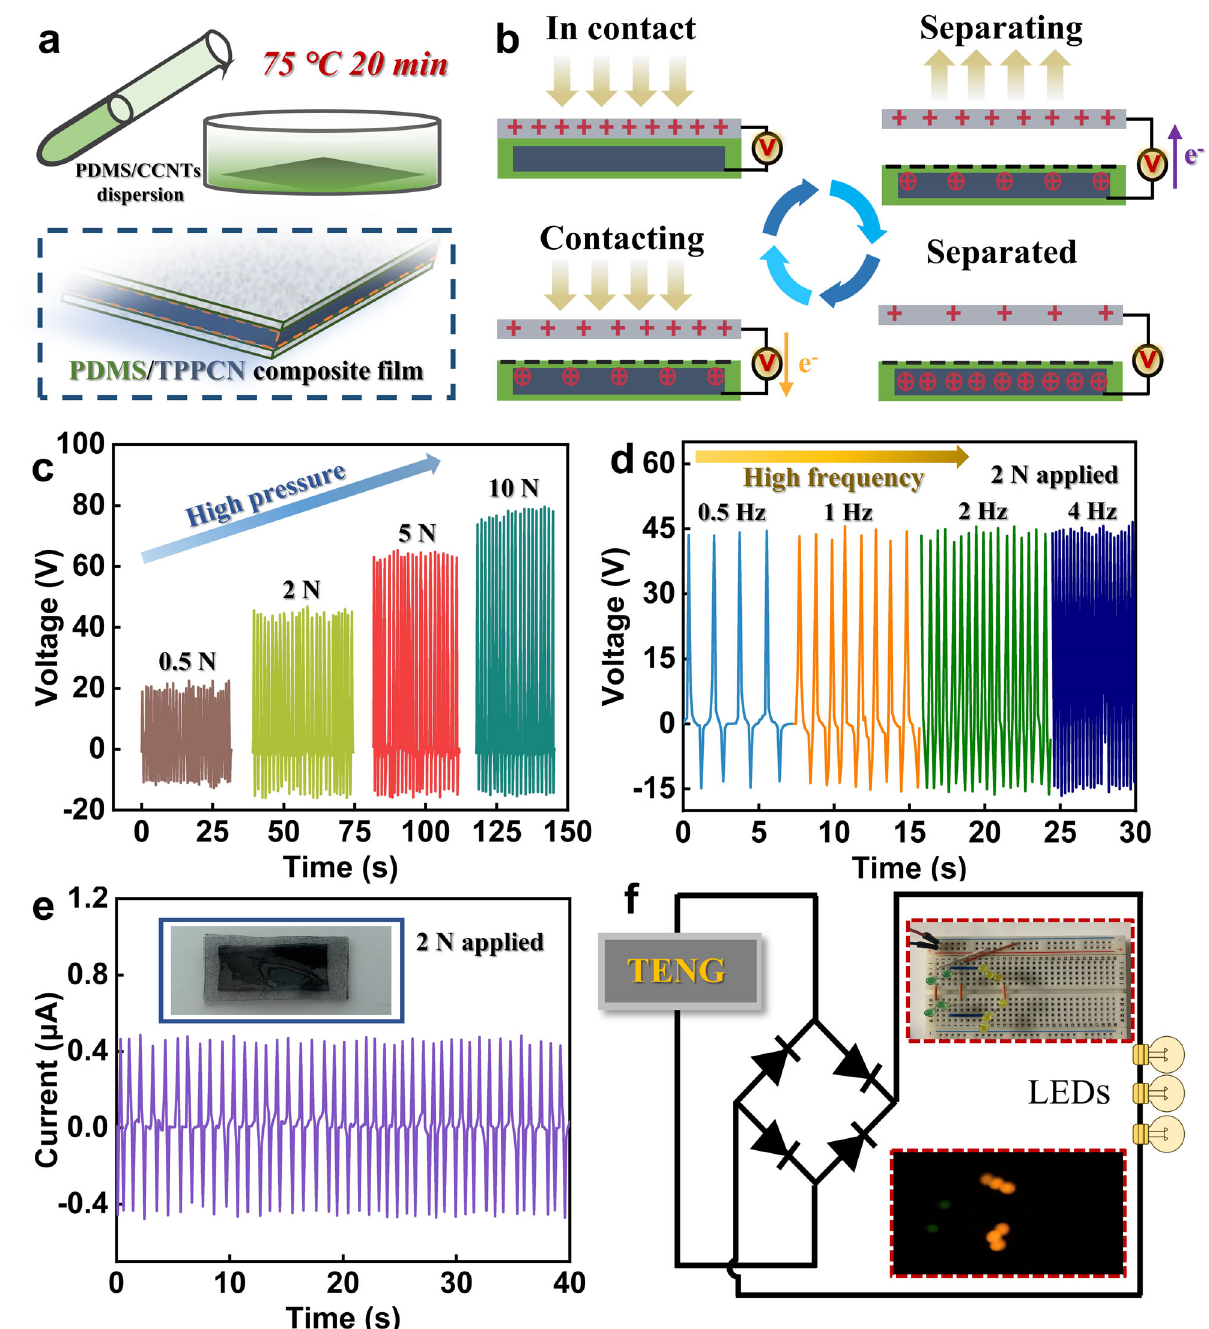
Fig. 7 Assembly and characterization of TPPCN-based TENG. a, b Preparation and works mechanism of TPPCN-based TENG with sandwich structure. c – e Output voltage of TENG with increased pressure, frequency, and corresponding output current with 2 N force applied. f LEDs in series were instantly turned on by a